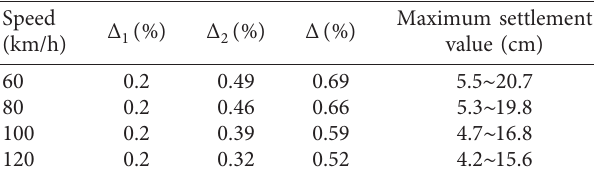
Table 5: Control criteria for differential settlement of short sub- grade at different speeds when 8m < L ≤ 30m.